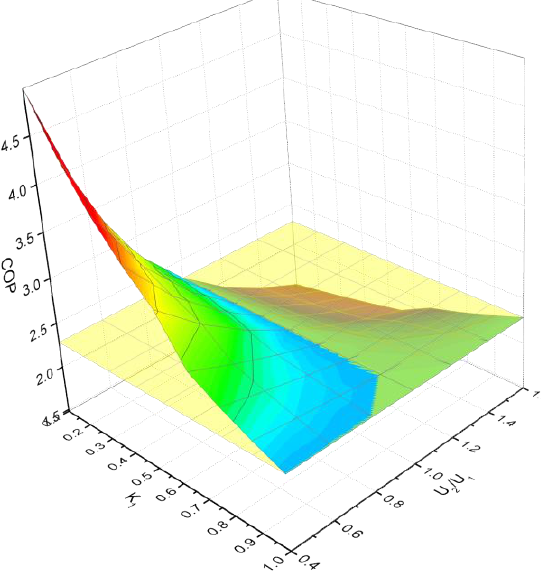
Figure 9. Coefficient of performance (COP) of the double-stage CDI system. Table 1. Parameters for COP evaluation.